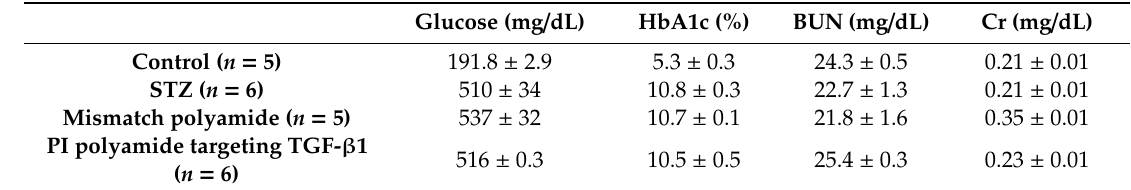
Table 1. Serological parameters of peripheral blood from Control rats and STZ diabetic rats without or with Mismatch polyamide or PI polyamide targeting TGF- β